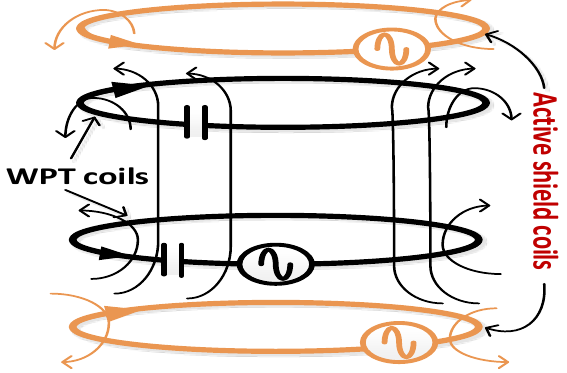
Figure 3. Active shielding using additional power